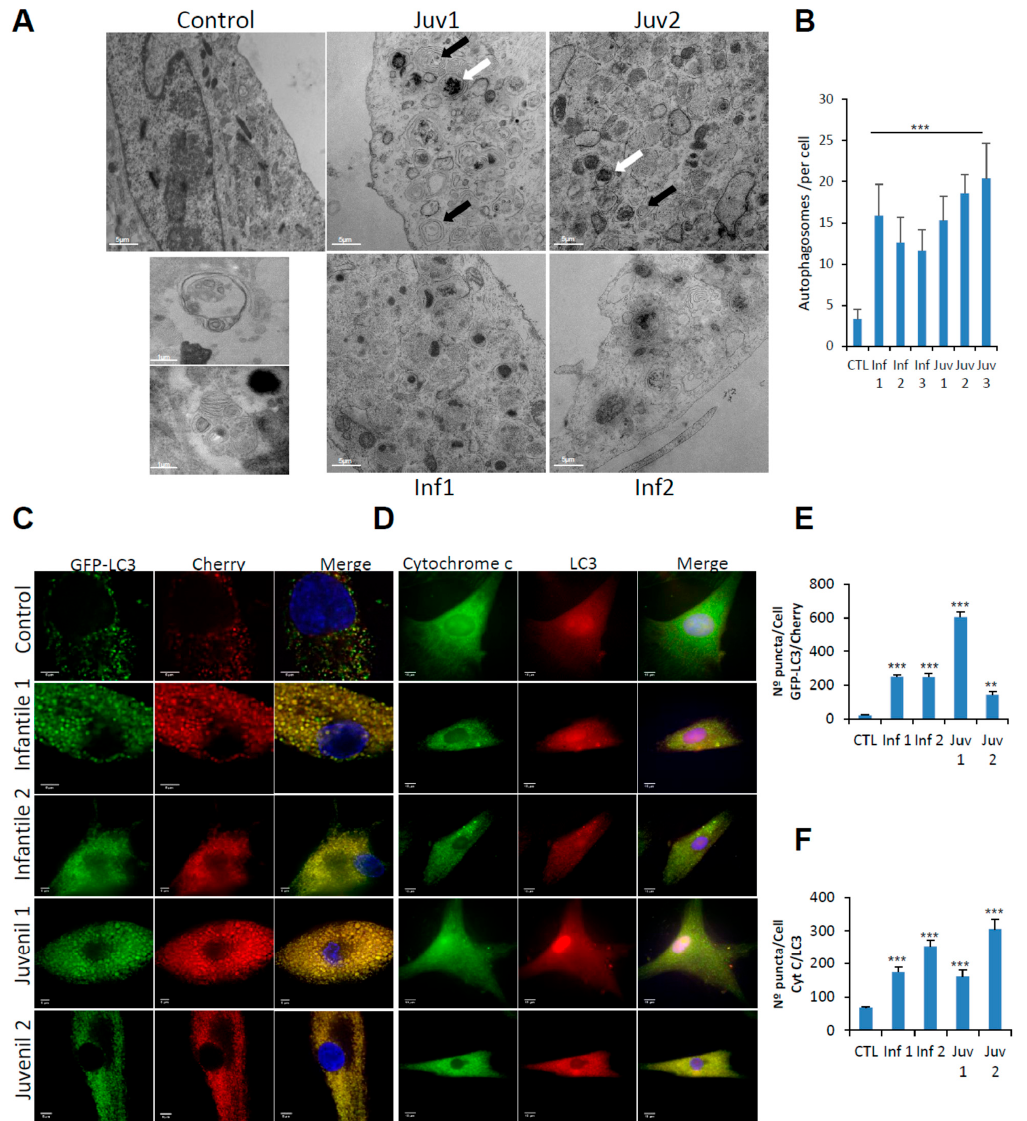
( F ). Cell growth determined in healthy and Tay–Sachs fibroblasts. ( G ). Expression of autophagy proteins in control and Tay–Sachs fibroblasts: LC3-I (top panels, top band), LC3-II (top panels, bottom band). ( H ). Immunofluorescence staining with anti-p62 antibody. ( I ). Impaired autophagic flux in Tay–Sachs fibroblasts. Determination of LC3-II in the presence and absence of bafilomycin A1 in control (CTL) and fibroblasts from Tay–Sachs patients; bafilomycin A1 was used at a final concentration of 100 nM with 12 h exposure. Total cellular extracts were analysed by immunoblotting with antibodies against LC3. The data are the mean ± SD for experiments conducted on two different control cell lines. Data represent the mean ± SD of three separate experiments. *** p < 0.001, ** p < 0.005, * p < 0.05 between cells from control subjects and patients with Tay–Sachs disease. a p < 0.05; aa p < 0.01; aaa p < 0.001.